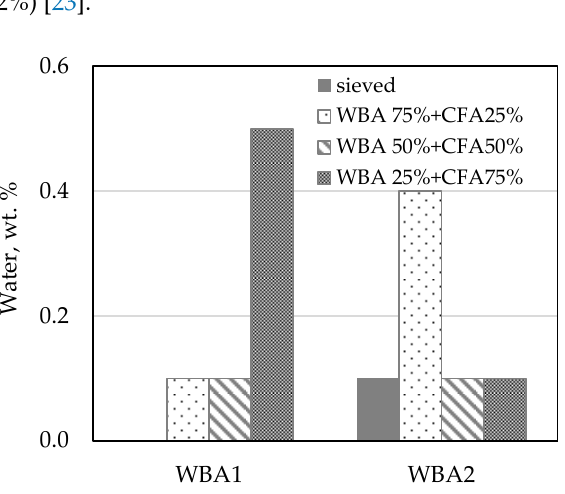
Figure 5. Free water content of WBA binders.